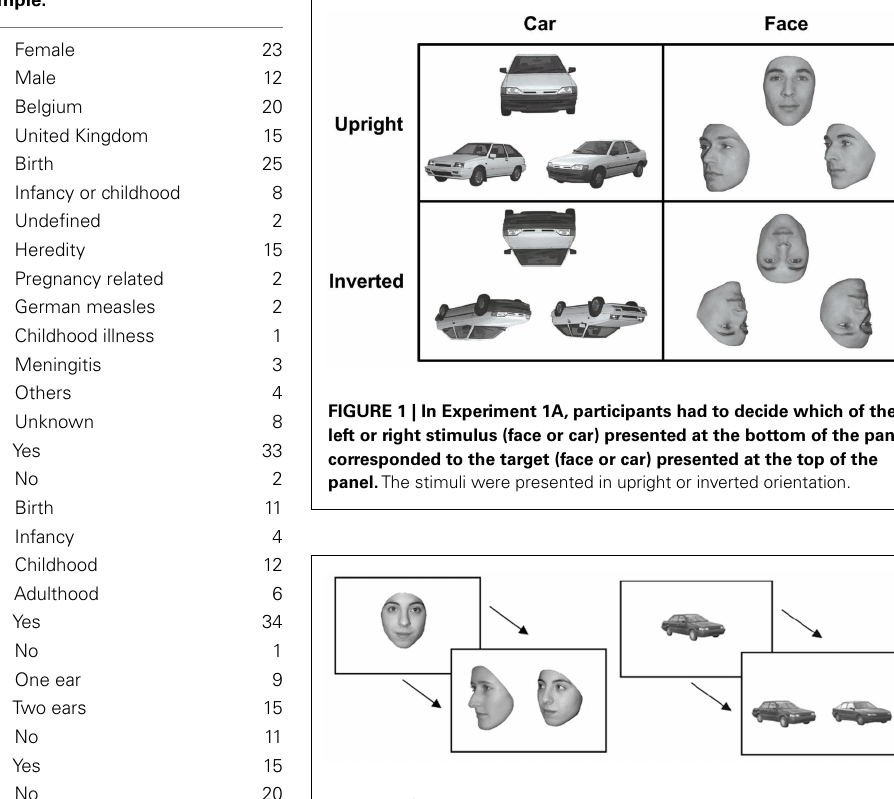
FIGURE 2 | In Experiment 1B, participants had to decide which of the left or right stimulus (face or car) presented on a second screen corresponded to the target (face or car) presented on the first screen. The stimuli were presented in upright or inverted